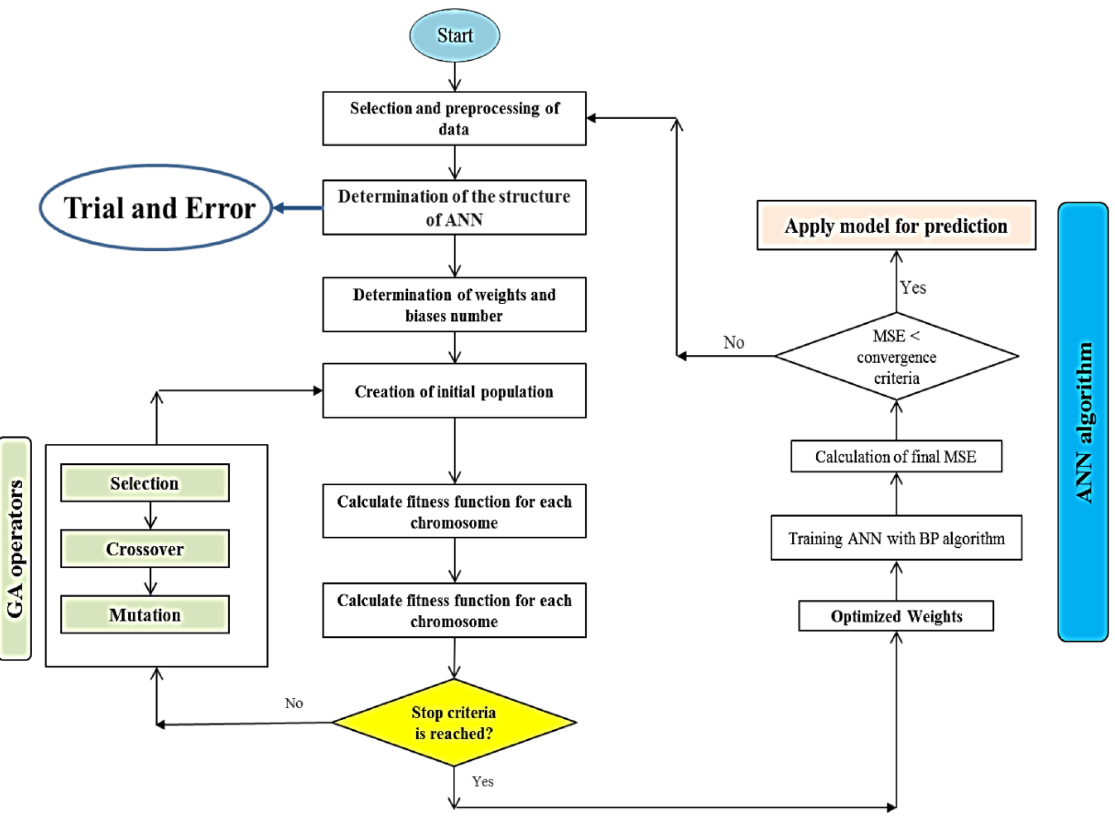
Figure 1. Flowchart of GA-ANN